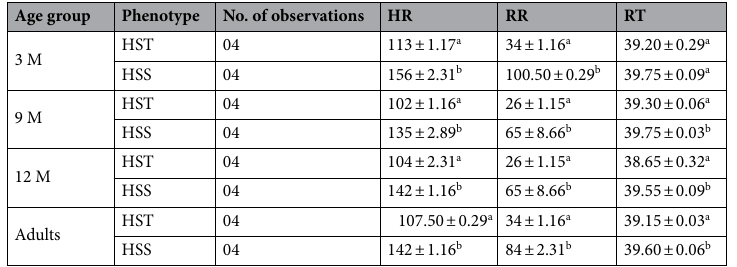
Table 3. Means of physiological responses (RT, RR and HR) of different age groups in heat stress-tolerant and susceptible phenotype during the heat stress period. No Number or sample size; 3 M 3-Month of age; 9 M 9-month of age; 12 M 12-month of age; Adults, 2–3 year age of animals; HST Heat stress tolerant; HSS Heat stress susceptible; RR Respiration rate (breaths/min); HR Heart Rate (beats/min); RT Rectal temperature in degree centigrade (°C). Means ± SE Means ± Standard error, means within the same rows with different superscripts are significantly different ( p < 0.01).